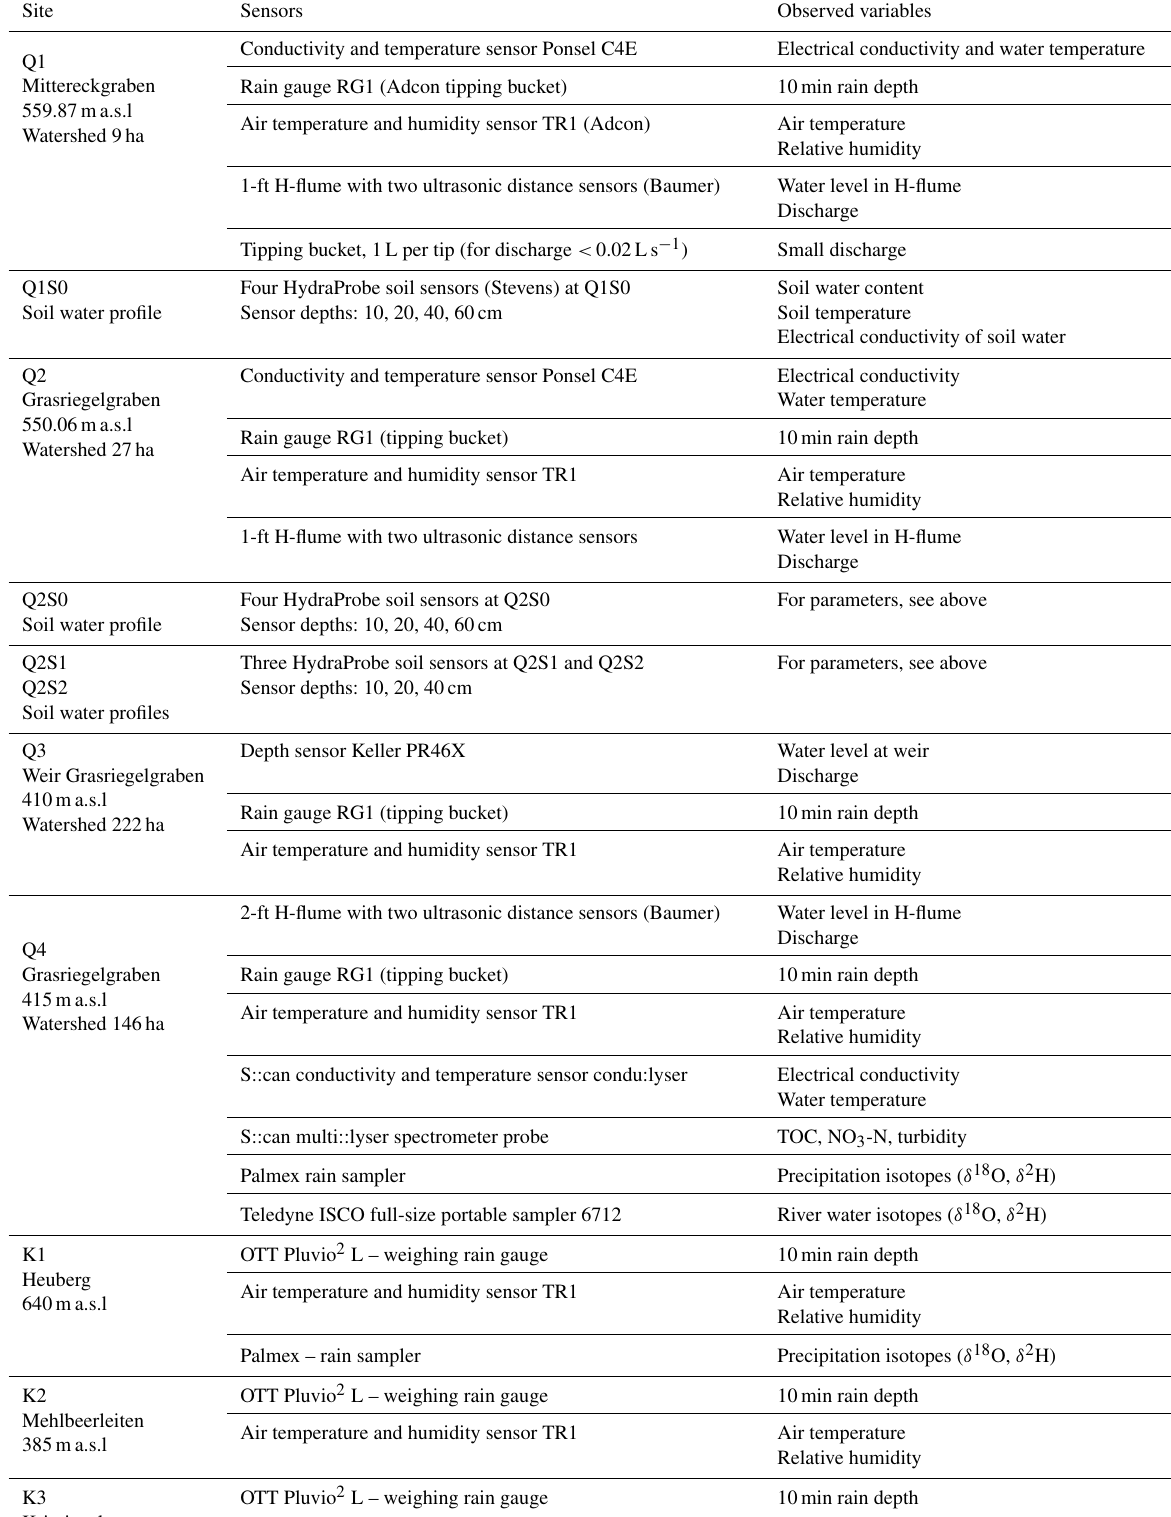
Table 1. List of sites, sensors and observed variables.